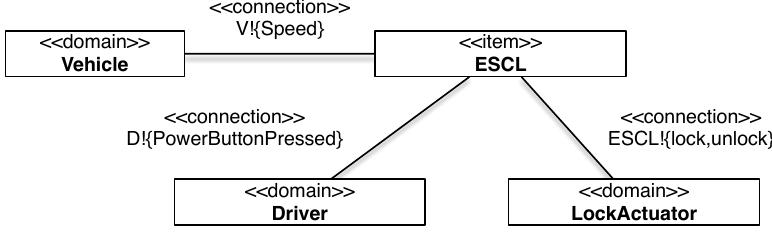
Figure 7. Electronic steering column lock (ESCL) Context Diagram based on [10].